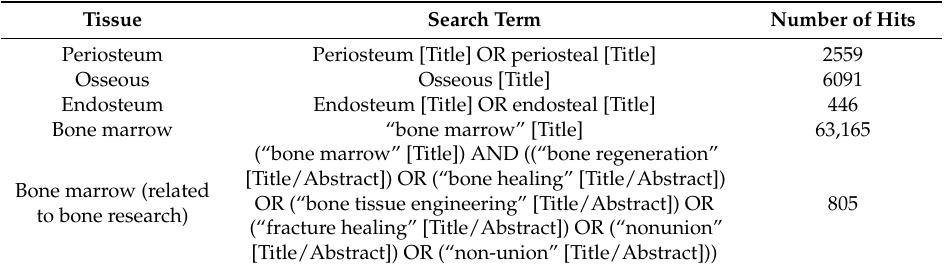
Table 1. Summary of terms used in the PubMed search conducted in October